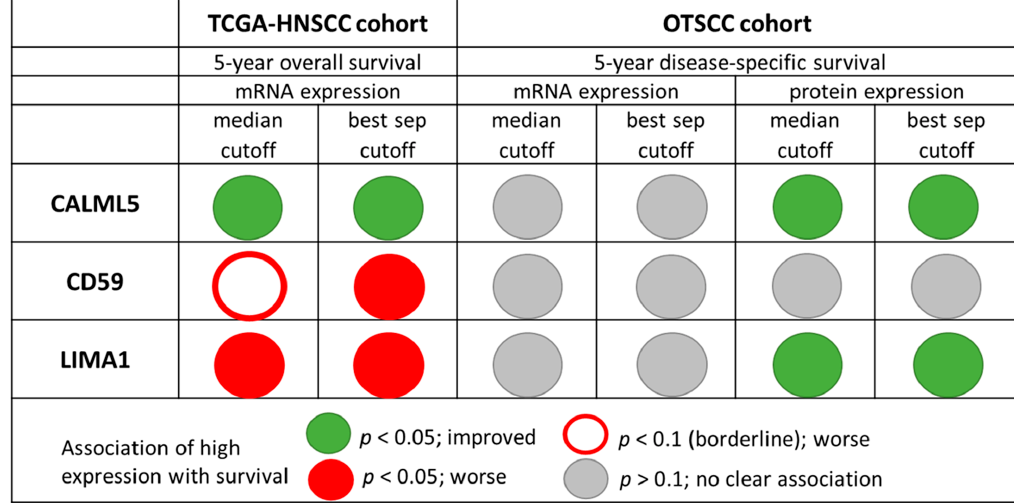
Figure 1. Association of high expression of CALML5, CD59, and LIMA1 mRNA and protein expression with 5-year overall survival in the TCGA head and neck cancer (TCGA-HNSCC) cohort and 5-year disease-specific survival in the oral tongue squamous cell carcinoma (OTSCC) cohort.